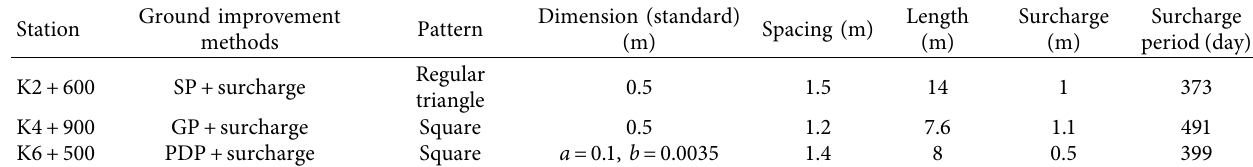
Table 3: Details of design parameters.